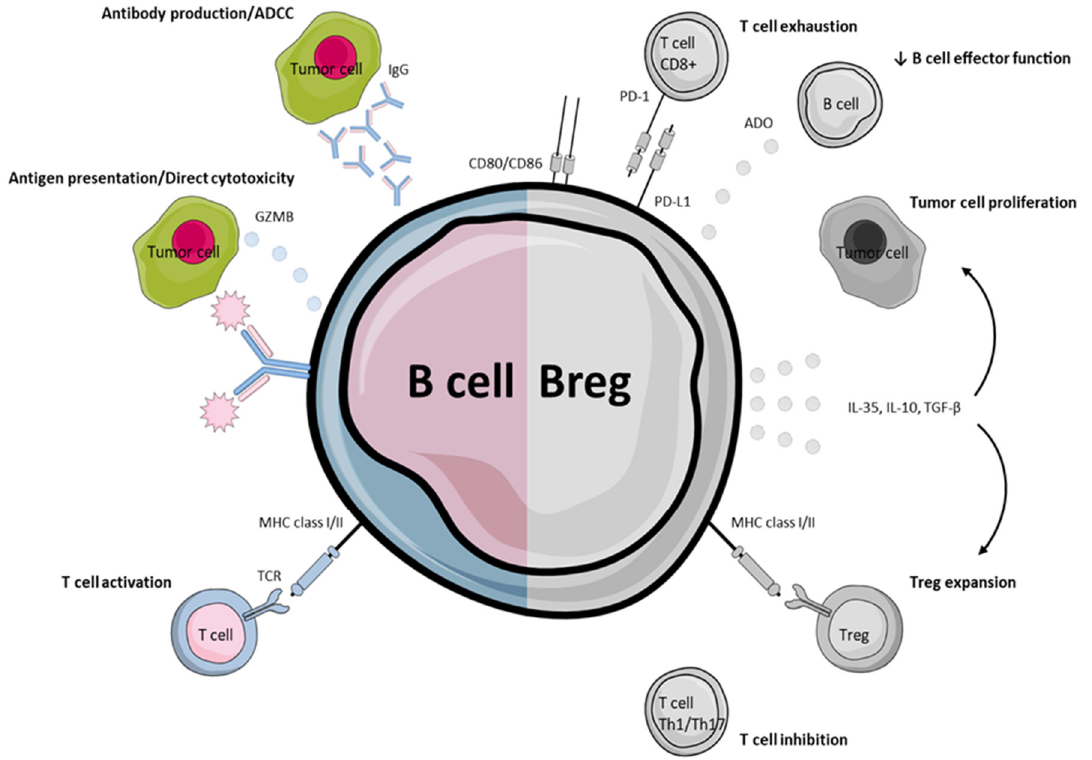
Figure 1. Demonstration of major B-cell functions within the TME. Effector B-cells, plasmablast and plasma cells enhance anti-tumor immunity by tumor-specific antibody production, ADCC, antigen presentation and T-cell activation (Left). Bregs, on the other hand, promote immunosuppression by T-cell exhaustion, effector B-cell inhibition, Treg expansion and tumor proliferation via inhibitory cytokine production. ADCC: antibody-dependent cell-mediated cytotoxicity; GZMB: granzyme B; TCR: T-cell receptor; MHC: major histocompatibility complex; ADO: adenosine; Th1: T helper cell type 1/17; TGF- β : Transforming growth factor ‐ beta.